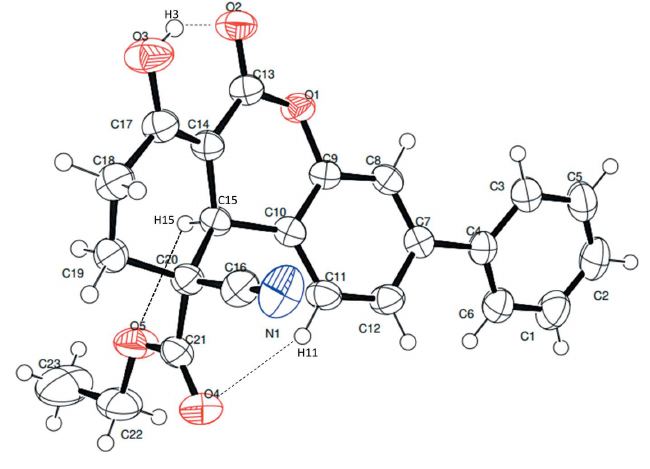
Figure 1 The molecular structure of the title compound with the atom-numbering scheme and displacement ellipsoids drawn at the 50% probability level. Intramolecular hydrogen bonds are shown as dashed